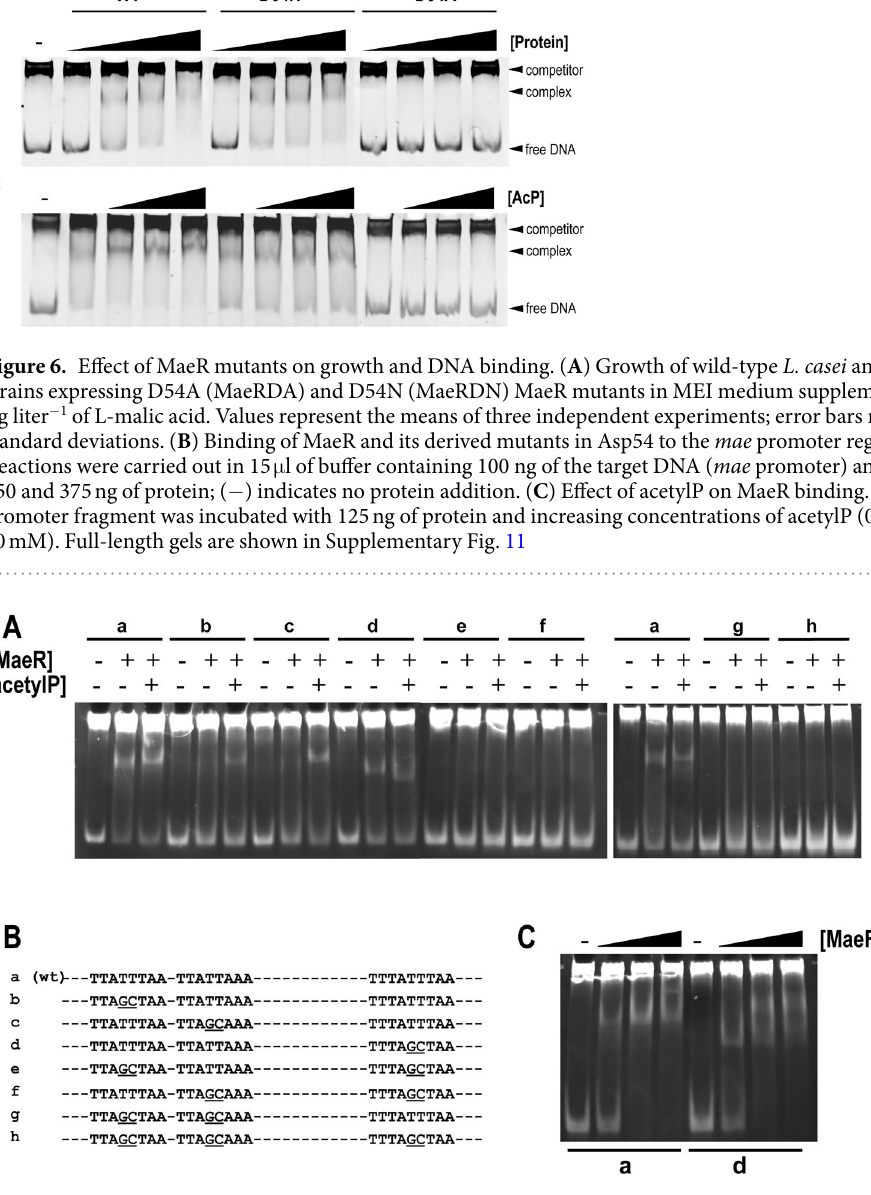
Figure 7. The effect of mutations in the direct repeats of the mae promoter on MaeR binding. ( A ) Different mae promoter fragments (80 bp; a, wild-type promoter; b to h, mutant forms shown in ( B ) were incubated with MaeR (125 ng) in the presence ( + ) or absence ( − ) of 10 mM acetylP. ( C ) Binding of MaeR to a fragment of the mae promoter: wild-type (fragment a) and a mutant in the third repeated sequence (fragment d).125, 250 and 375 ng of MaeR were added and the binding was performed in the presence of 10 mM acetylP. Full-length gels are shown in Supplementary Fig.